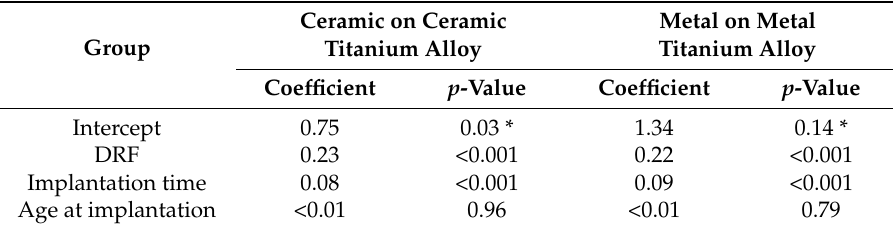
Table 3. Results of stepwise analysis (dependent variable: HNJ damage score).